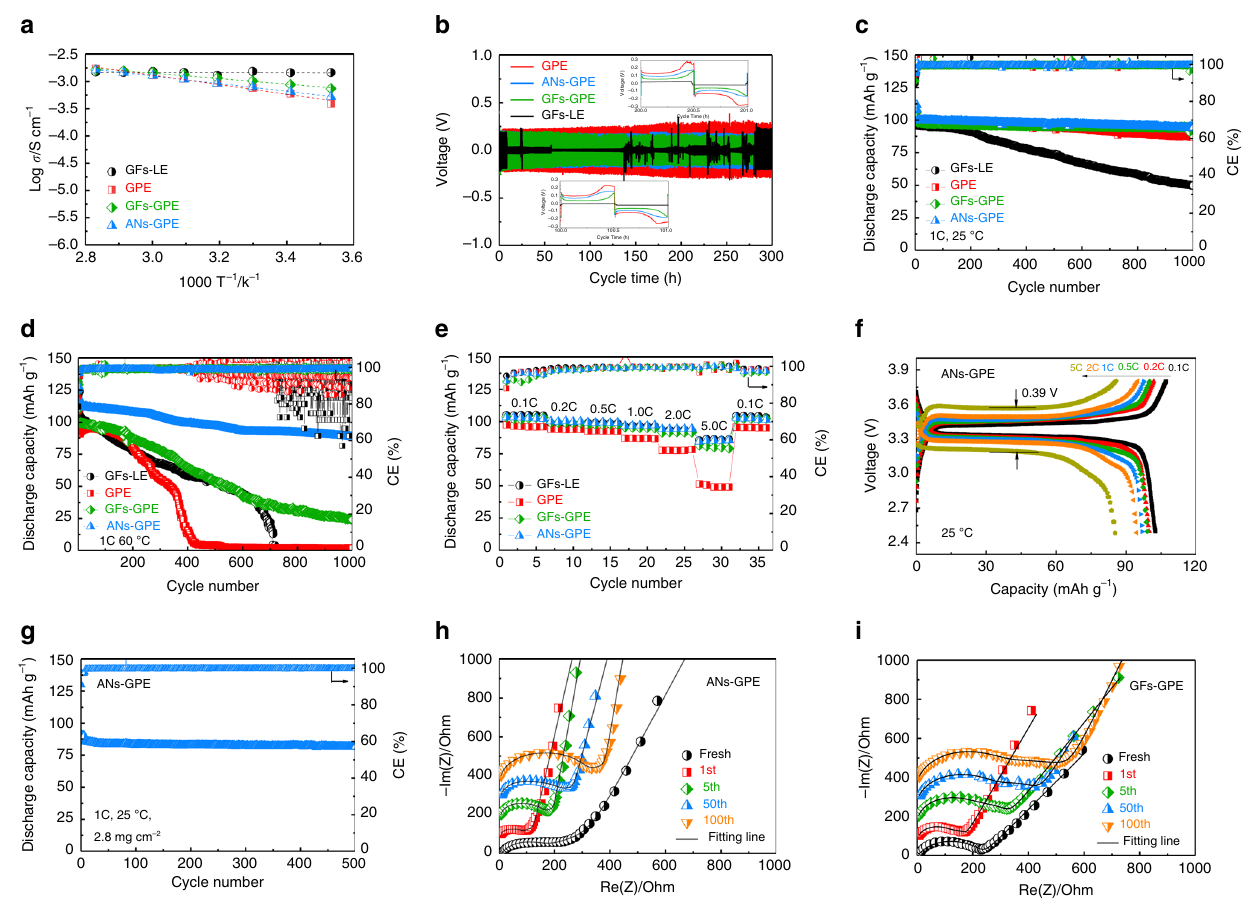
Fig. 3 Electrochemical characterizations of ANs – GPE-based cells. a Ionic conductivities of GFs – LE, GPE, GFs – GPE, and ANs – GPE. b Galvanostatic cycling curves of Na/Na symmetrical cells using GFs – LE, GPE, GFs – GPE, and ANs – GPE at a current density of 0.5 mA cm − 2 . c , d Long-term cycling performance of NVP/Na cells using GFs – LE, GPE, GFs – GPE, and ANs – GPE at 1 C under 25 °C and 60 °C. e Rate performance of NVP/Na cells using GFs – LE, GPE, GFs – GPE, and ANs – GPE. f Charge/discharge curves of Na/ANs – GPE/Na symmetrical cells from 0.1 to 5 C. g Cycling performance of NVP/ANs – GPE/Na cells